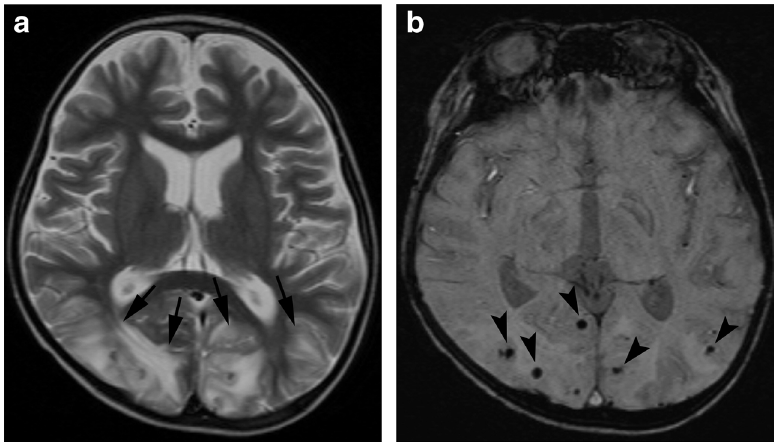
Fig. 6 Posterior reversible encephalopathy syndrome.